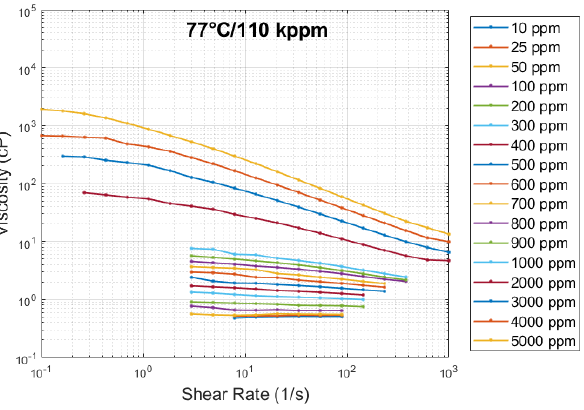
Figure 10: Flow curves graph at 77 ∘ C and 110,000 ppm of NaCl